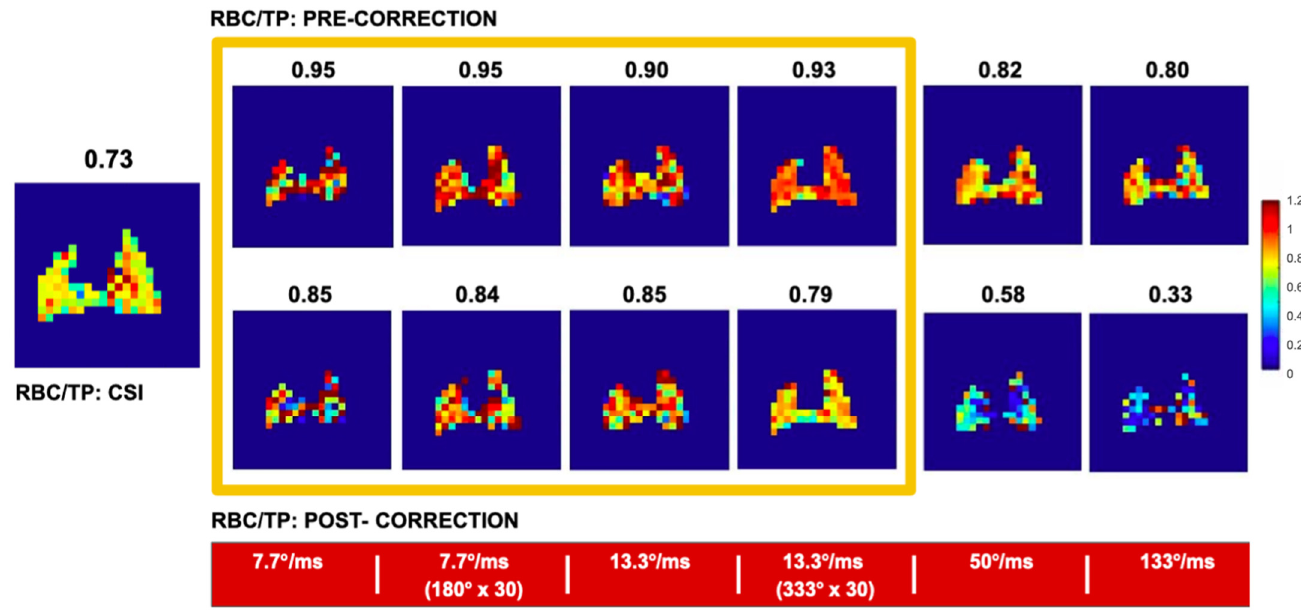
Figure 24. RBC/TP ratio maps compared to approximately equivalent ratio maps based on XTC MRI measurements using six different saturation schemes with average flip angle rates ranging from 7.7 ◦ /ms to 133 ◦ /ms, with and without correction for off-resonance excitation. Saturation schemes are either continuous, and specified by the flip-angle per ms, or discrete, specified by both average flip-angle per ms and the flip-angle x the number of saturation pulses applied (bottom red bar). Mean ratios consistently decrease to approach the ‘true’ value observed using direct Chemical Shift Imaging of the dissolved phase (left) and increase in fidelity as signal-to-noise is increased (left to right inside yellow box), but ultimately fail at the highest saturation power due to the off-resonance effects explained in Figure 23. Reprinted with permission from Achekzai, et al. ( Magn Reson Med 2022, ref.